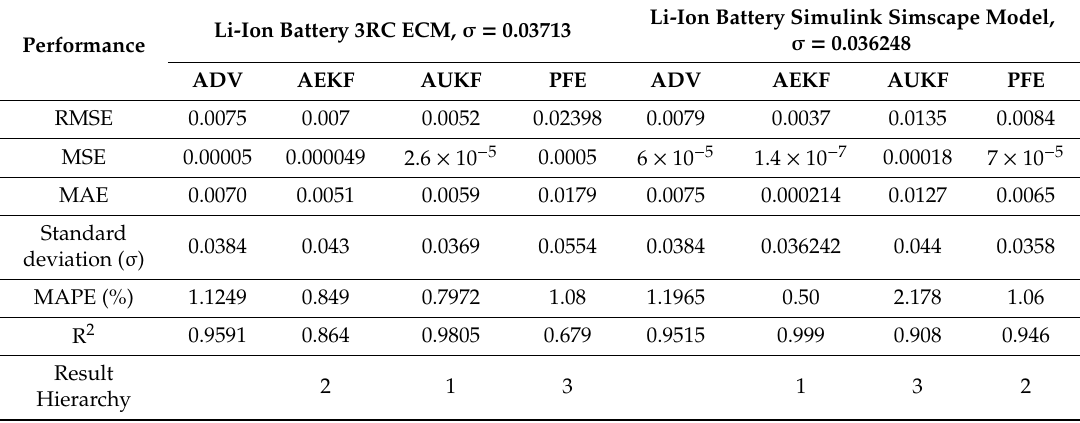
Table 1. Statistical criteria—state of charge (SOC) estimators (default value SOCini = 0.7).